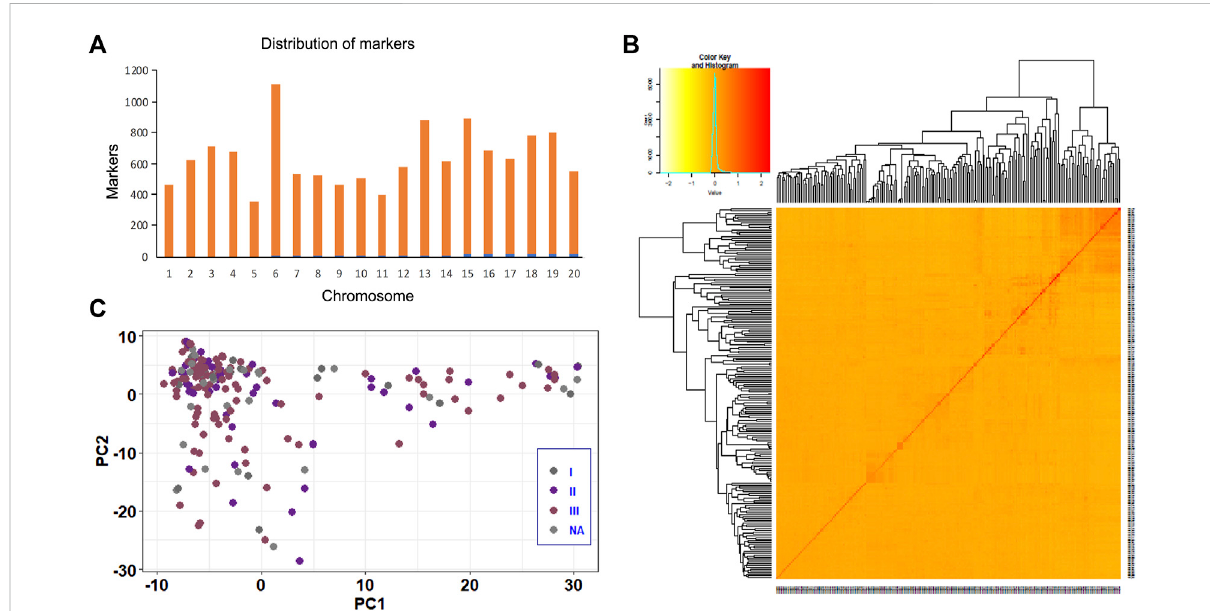
FIGURE 2 Kinship plot and population structure analysis of the soybean panel using 12,617 SNP markers. (A) Distribution of 12,617 SNP markers across 20 soybean chromosomesused for GWAS and GP analysis. (B) Kinship plot depicting therelationship among 211 soybean genotypes. (C) Population structure analysis of 211 soybean genotypes.